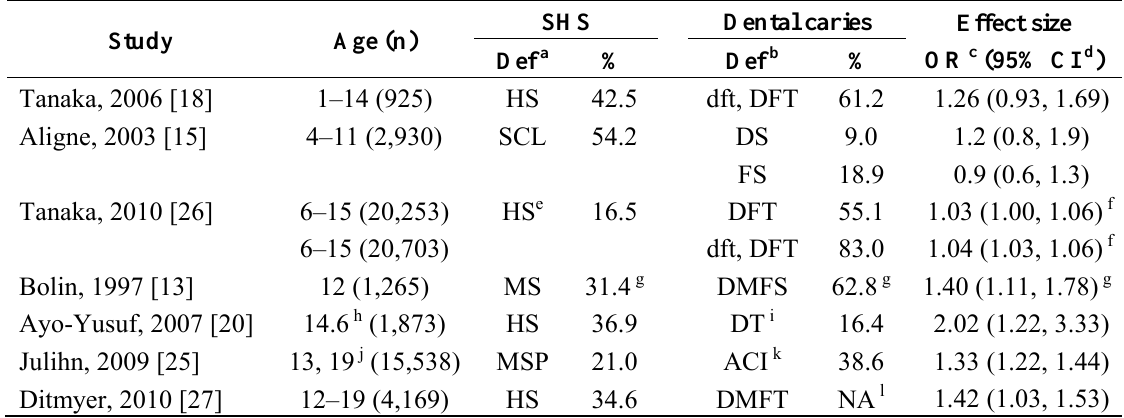
Table 4. Relationship between SHS exposure and caries of permanent teeth sorted by age of children.